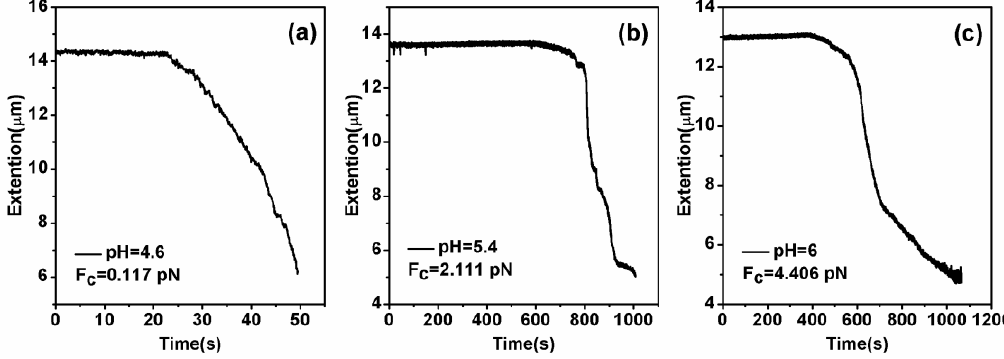
Figure 6. DNA extension as a function of pulling time. ( a ) – ( f ): The cases of different pHs (pH = 4.6, pH = 5.4, pH = 6, pH = 7, pH = 7.5 and pH = 8) with a fixed chitosan concentration 20 µM.